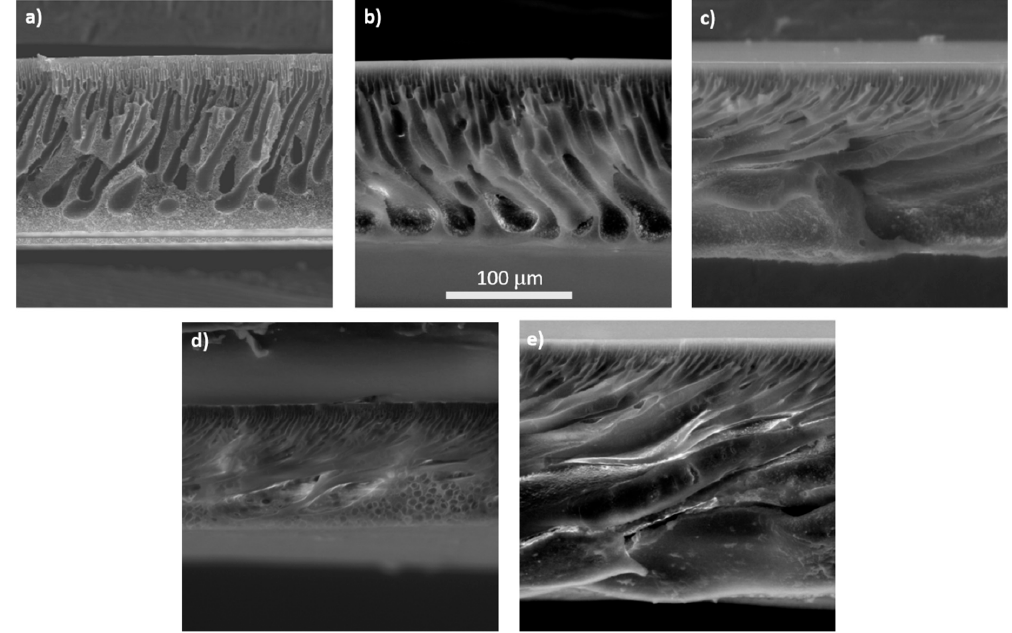
Figure 4. Environmental scanning electron microscope (ESEM) micrographs of the cross-section of PSf-mG20 membranes: ( a ) L0; ( b ) L2; ( c ) L5; ( d ) L10; ( e ) L20.